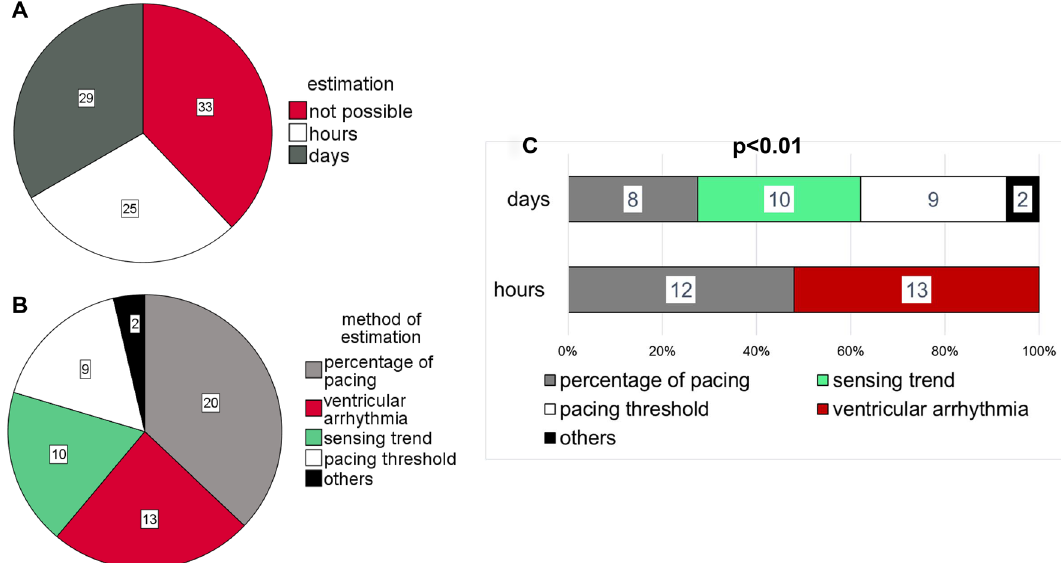
Figure 3. ( A ): Pie chart depicting the success of the determination of time of death (not possible, exact within a day, exact within an hour). ( B ): Primary method of estimation is depicted. ( C ): A significant difference in the primary method of estimation is visualized between CIED with an estimation of time of death within an exact hour and within a day ( p < 0.01).